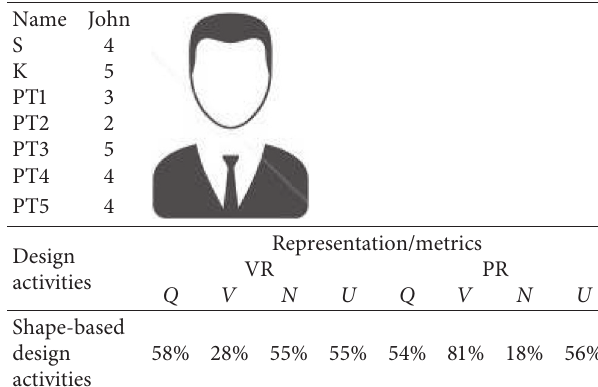
Table 2: Designer record of a specific